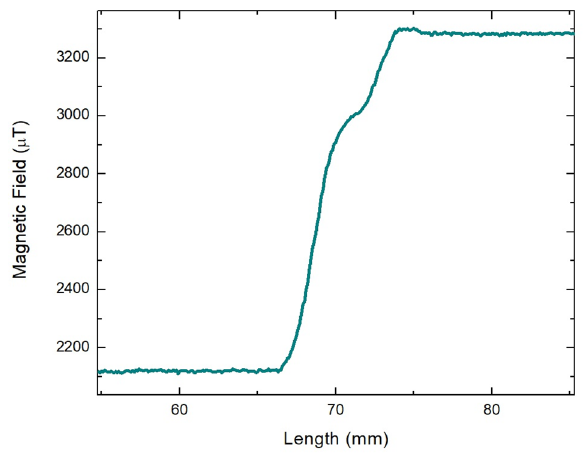
Fig. 20 Experimental result of magnetic field Y of a rectangular defect C1 with ordered magnetic domains